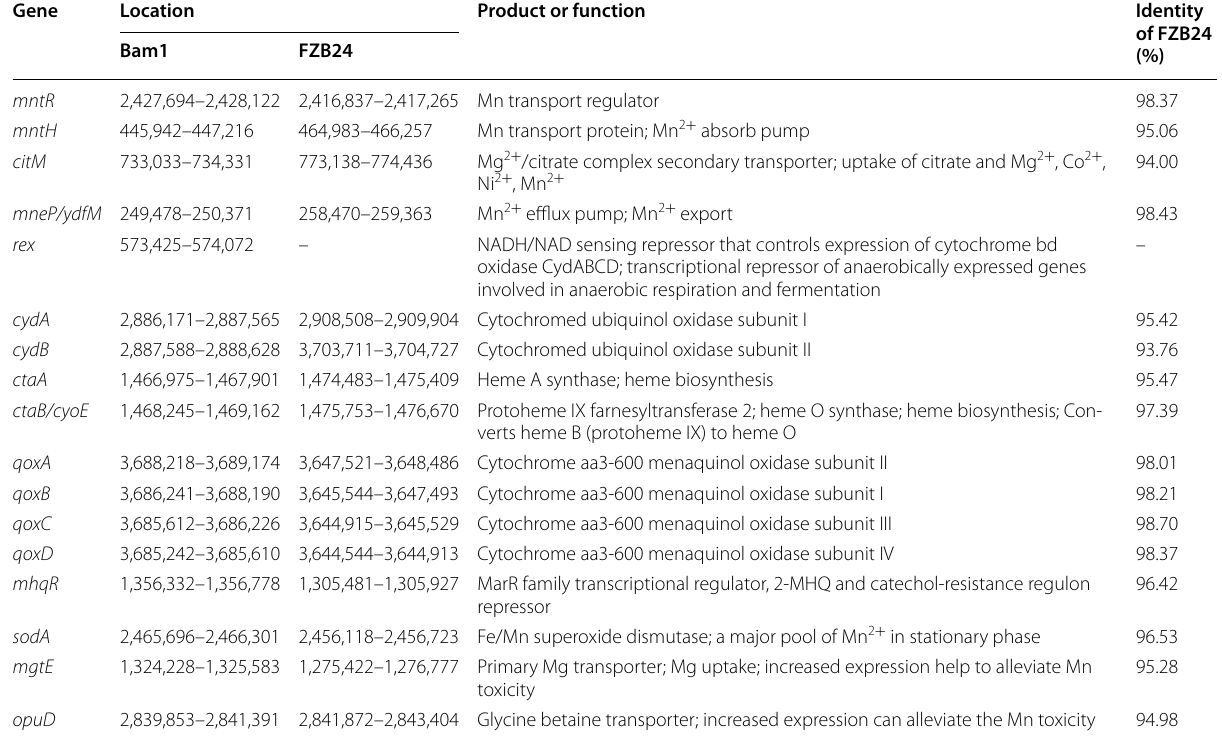
Table 3 Genes involved in Mn resistance in B. amyloliquefaciens strain Bam1 and B. velezensis strain FZB42